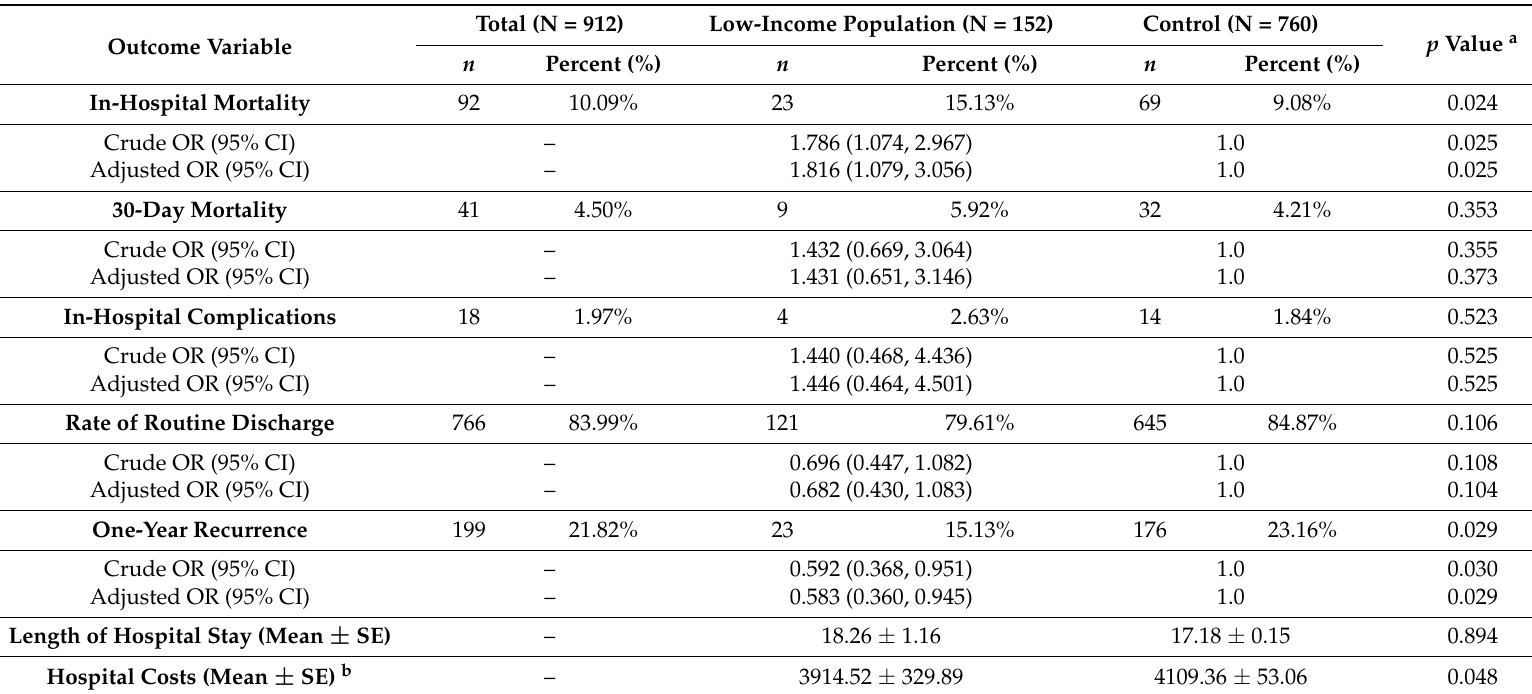
Table 3. Prevalence and odds ratios (ORs) for in-hospital mortality, 30-day mortality, in-hospital complications, routine discharge rate, and one-year recurrence among sampled subjects after propensity score